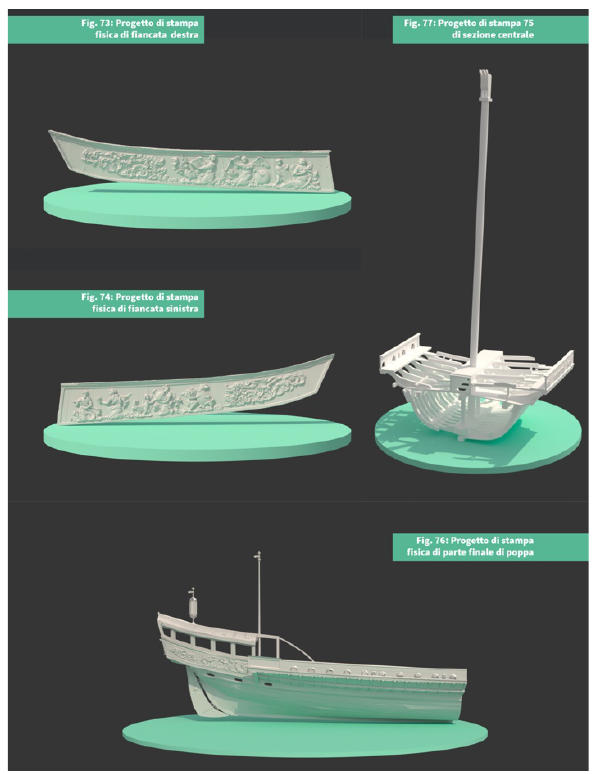
Figure 10. Renderings of the final digital